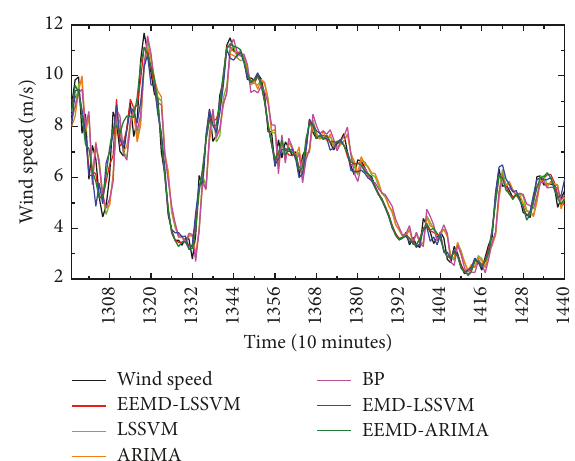
Figure 6: One-step-ahead forecasting results (Case